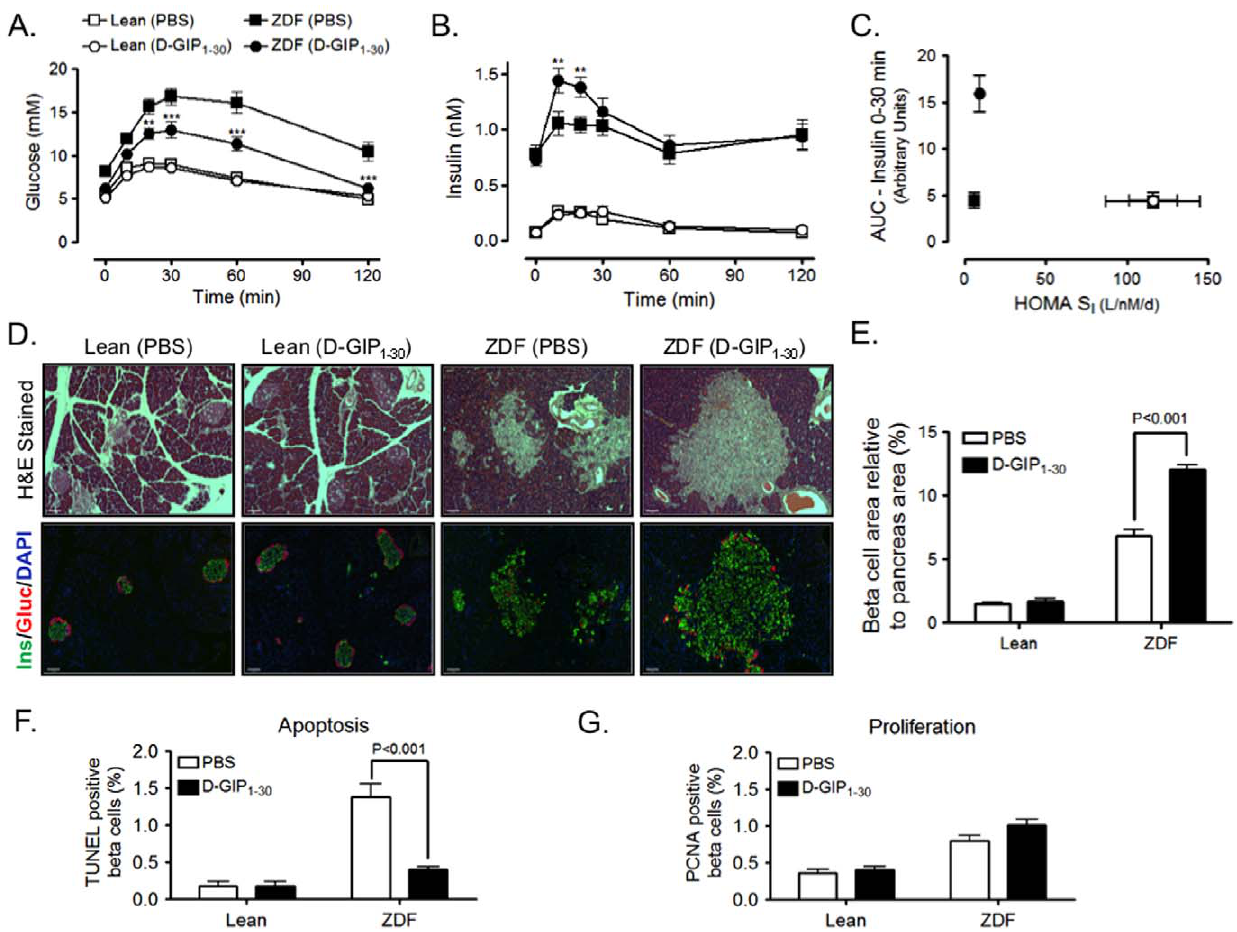
Figure 5. D-GIP 1–30 improves b -cell function and mass and glucose tolerance in ZDF rats. A , OGTTs were performed on fasted Lean and ZDF rats (described in figure 4) , 48 h following the last day of treatment and blood glucose levels were measured. Mean 6 SEM (n=6); **, p , 0.01, ***, p , 0.001 vs ZDF rats treated with PBS. B , Insulin levels were determined from blood samples collected in A . Mean 6 SEM (n=6); **, p , 0.01 vs ZDF rats treated with PBS. C , Integrated acute insulin response (from 0 to 30 minutes) for profiles described in B was plotted with respect to HOMA S I . Mean 6 SEM (n=6). D , Representative images of pancreases collected , 24 h following OGTTs. Pancreases were stained with hematoxylin & eosin or with insulin (green), glucagon (red) and DAPI (blue); scale bar=100 m m. E , Mean 6 SEM of b -cell (insulin positive) area relative to pancreas area (n=3; 4 sections per animal); significance as shown. E , Mean percent 6 SEM of b -cells undergoing apoptosis as determined via TUNEL positive nuclei (n=6); significance as shown. F , Mean percent 6 SEM of -cells undergoing proliferation as determined via PCNA positive nuclei